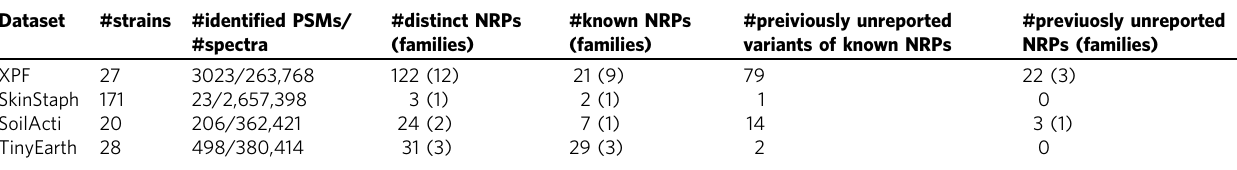
Table 1 Summary of NRPminer search results on the XPF, SkinStaph, SoilActi, and TinyEarth datasets.